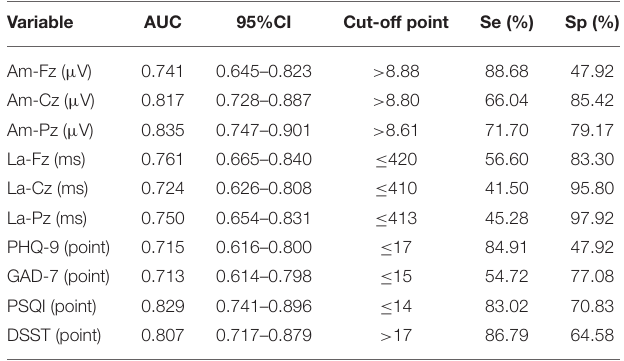
TABLE 9 | Comparison of the ROC curves for different markers in predicting the therapeutic effect. Variable